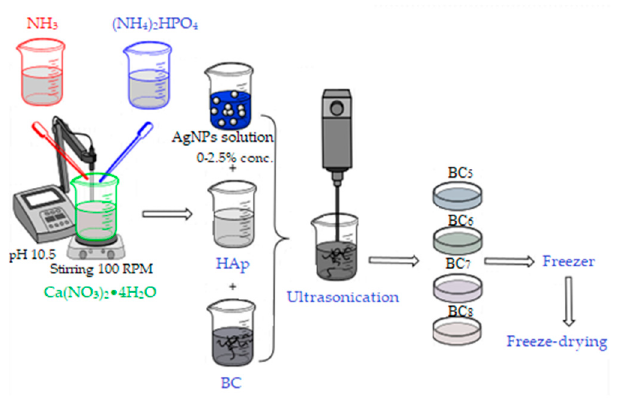
Figure 3. Synthesis of BC 5 , BC 6 , BC 7 , and BC 8 composites.